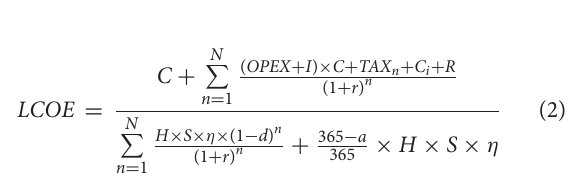
FIGURE 3 | DEM technology map. Source: Platform for geographical situation monitoring of